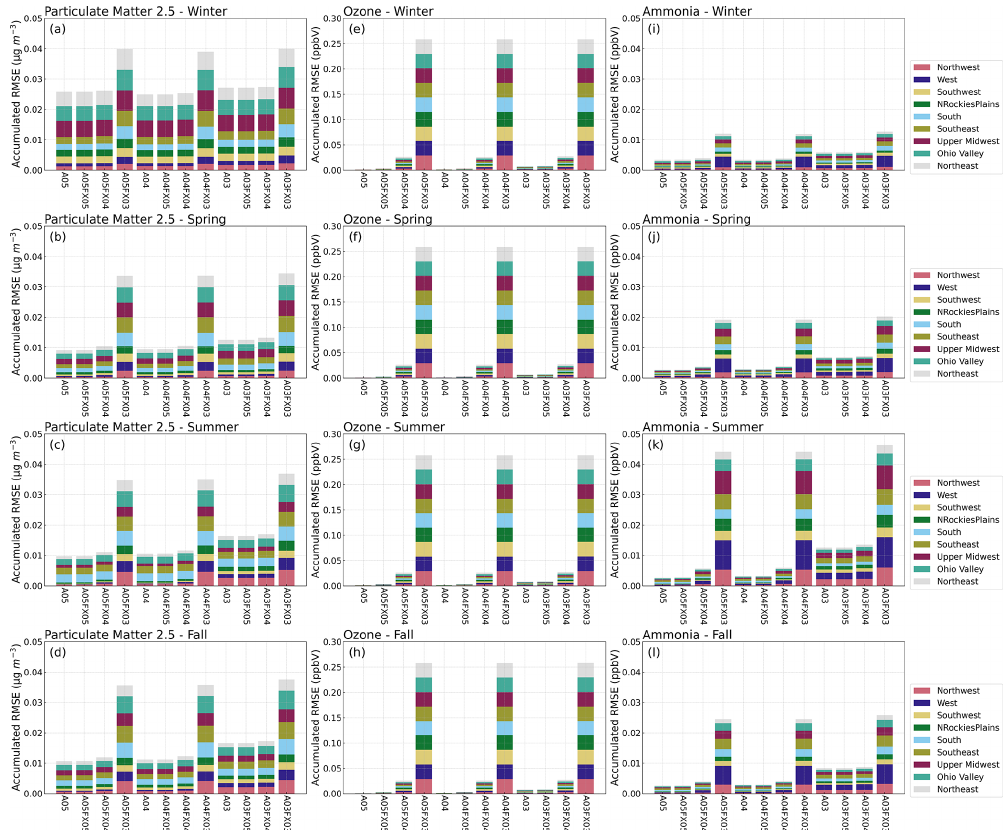
Figure 6. Stacked bar plots of changes to RMSE ( y axis) stratified by region (color), simulation and case ( x axis), and season (subplot) for hourly PM 2 . 5 , O 3 , and NH 3 calculated from grid–grid pairs with respect to the orig simulation.